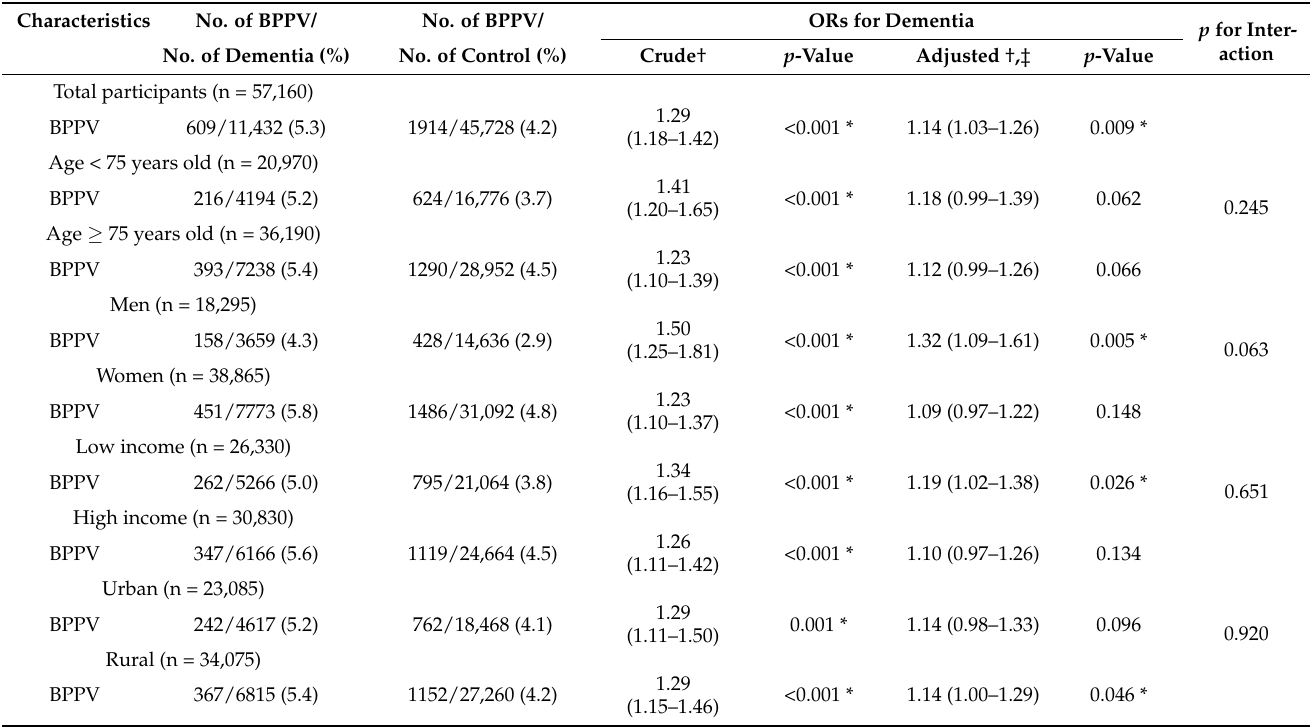
Table 2. Crude and adjusted odds ratios (95% confidence interval) of BPPV for dementia and in subgroup analysis according to age, sex, income, and region of residence.